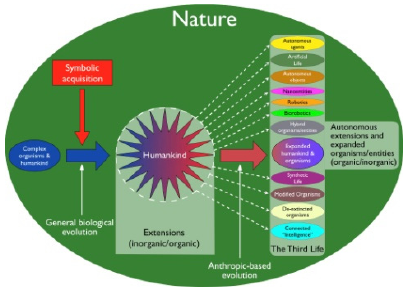
Figure 2. The Third